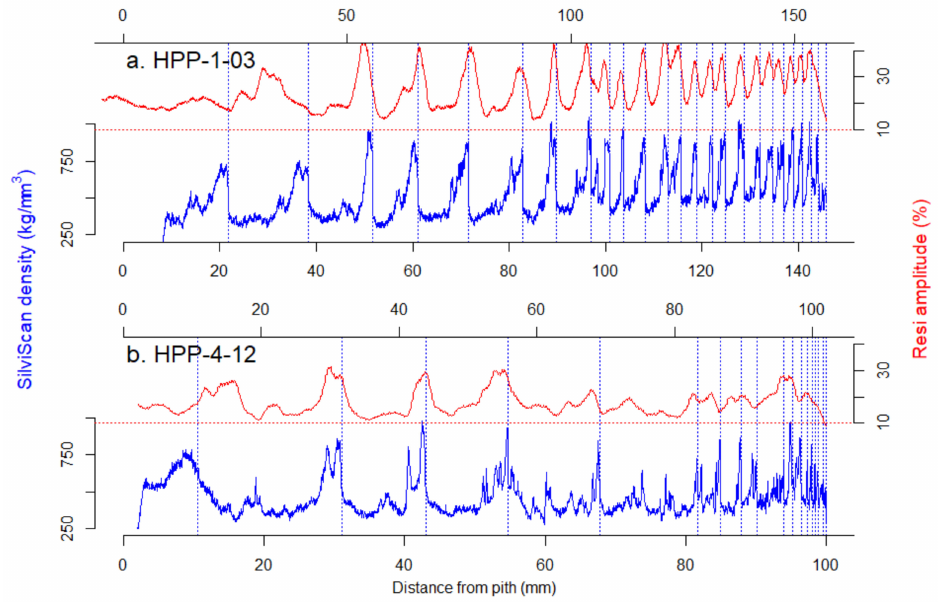
Figure 7. Narrow and false ring structures made accurate annual ring detection impossible in many samples, especially in the lower-resolution Resi (upper red) traces compared to the SilviScan (lower blue) profiles. ( a ) good correspondence between the Resi traces and SS profiles and evident. In contrast ( b ) illustrates a samples where annual ring structure is unclear in both the Resi and SS data. Blue vertical lines indicate annual ring positions allocated in SilviScan